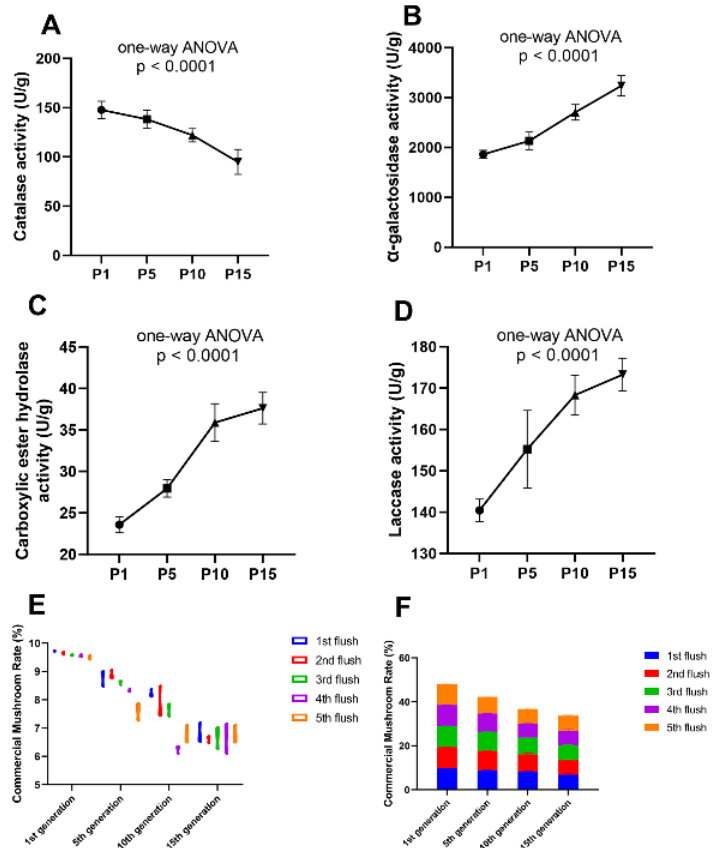
Figure 8. Enzymatic activity assay of the metabolic enzymes in different subcultured generations and the ultimate yield after fruiting. The catalase activity ( A ) decreased with the increase of subcultured generations, the α-galactosidase ( B ), carboxylic ester hydrolase ( C ), and laccase activity ( D ) increased with the increase of subcultured generations. The commercial mushroom rate (CMR) was gradually decreased with the increase of subcultured generation in each ( E ) and all five flushes ( F ).